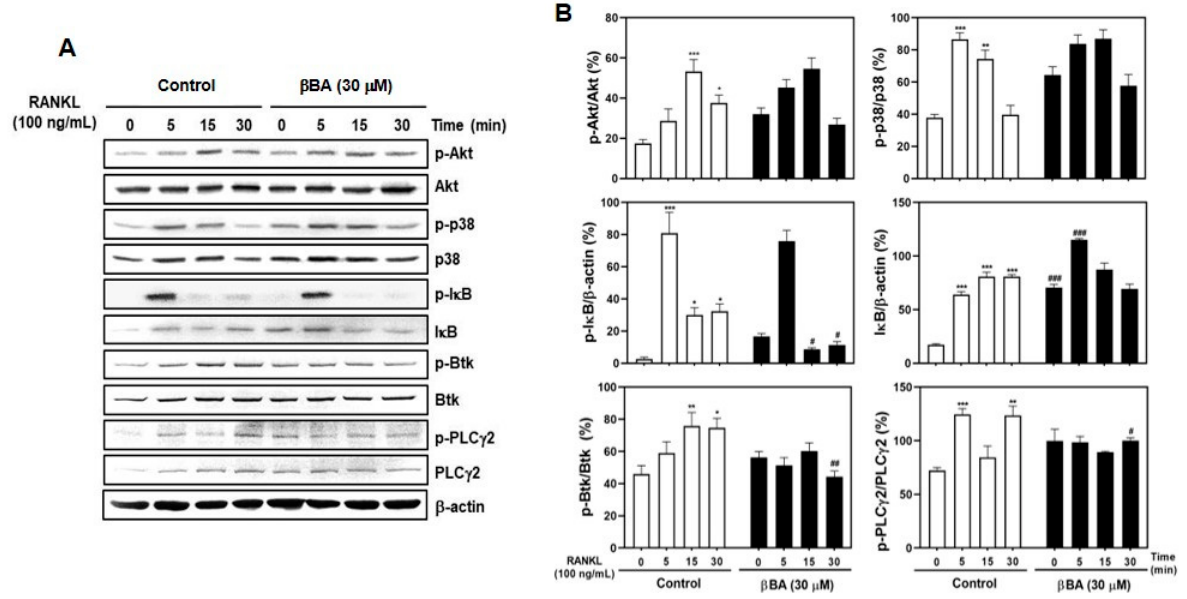
Figure 3. β -boswellic acid ( β BA) downregulates RANKL-induced phosphorylation of I κ B, Btk, and PLC γ 2 and I κ B degradation. Mouse bone marrow-derived macrophages (BMMs) were starved with serum-free α -MEM media for 3 h. BMMs were pre-treated with DMSO control or β BA (30 μ M) for 1 h and then stimulated with RANKL (100 ng/mL) at the indicated times. ( A ) The cell lysates were analyzed by Western blotting with antibodies. β -actin was used as internal control. ( B ) Quantification of relative ratio of band intensity was performed using Image J software. Data represent means ± SD (n = 3). * p < 0.05, ** p < 0.01, *** p < 0.001 vs. control at 0 min; # p < 0.05, ## p < 0.01, ### p < 0. as compared with DMSO control at the indicated time.